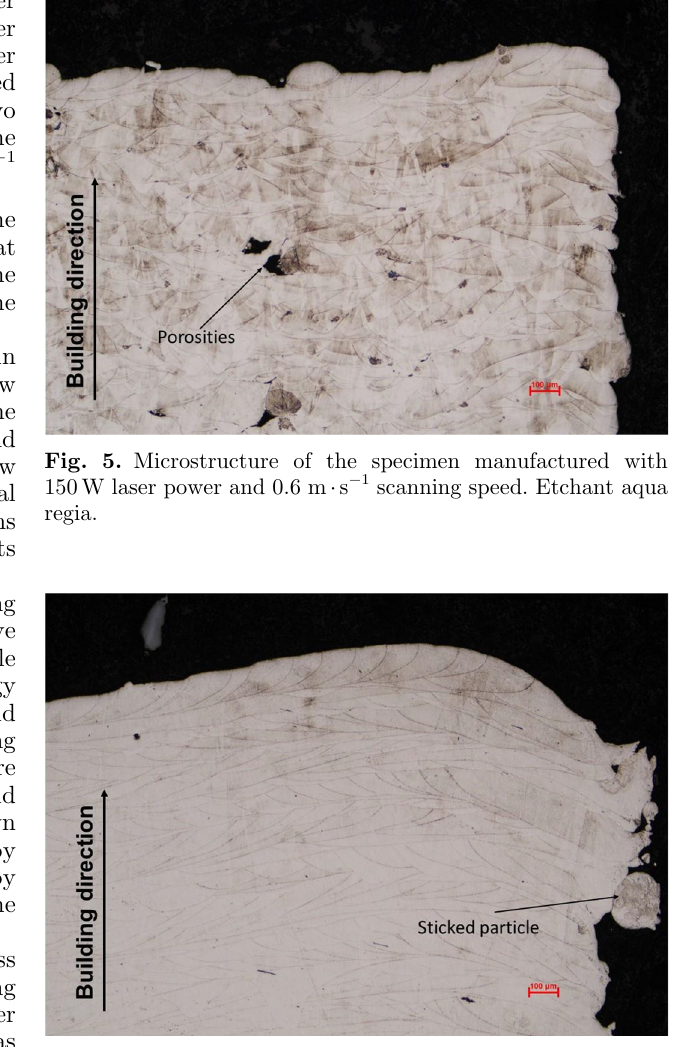
Fig. 6. Microstructure of the specimen manufactured with 400 W laser power and 0.6 m · s (cid:3) 1 scanning speed. Etchant aqua